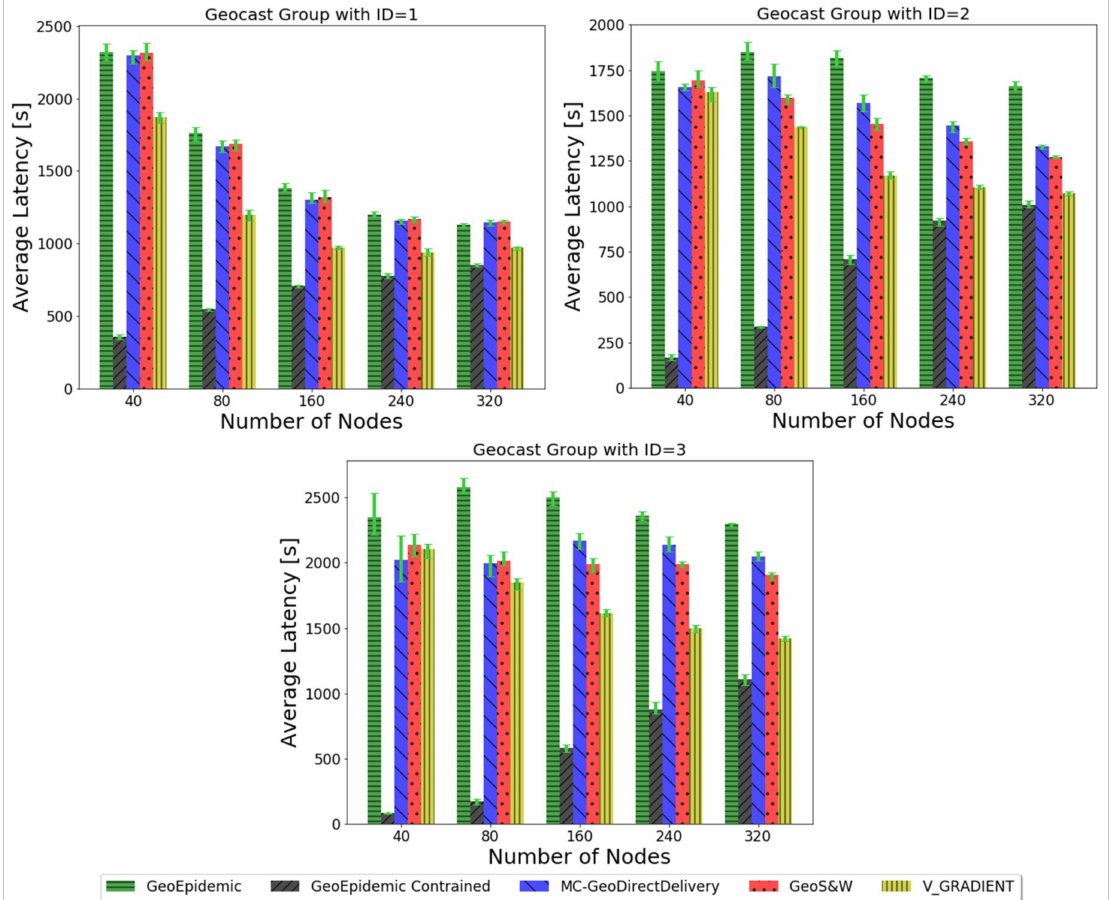
Figure 8. Delivery latency as a function of node density, protocol, and geocast